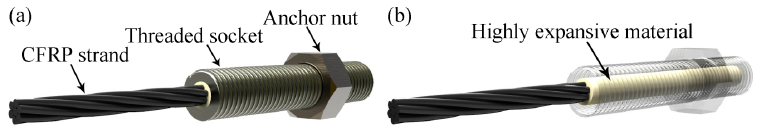
Figure 21. Highly Expansive Material Filling Anchorage, ( a ) full view and ( b ) transparent view.